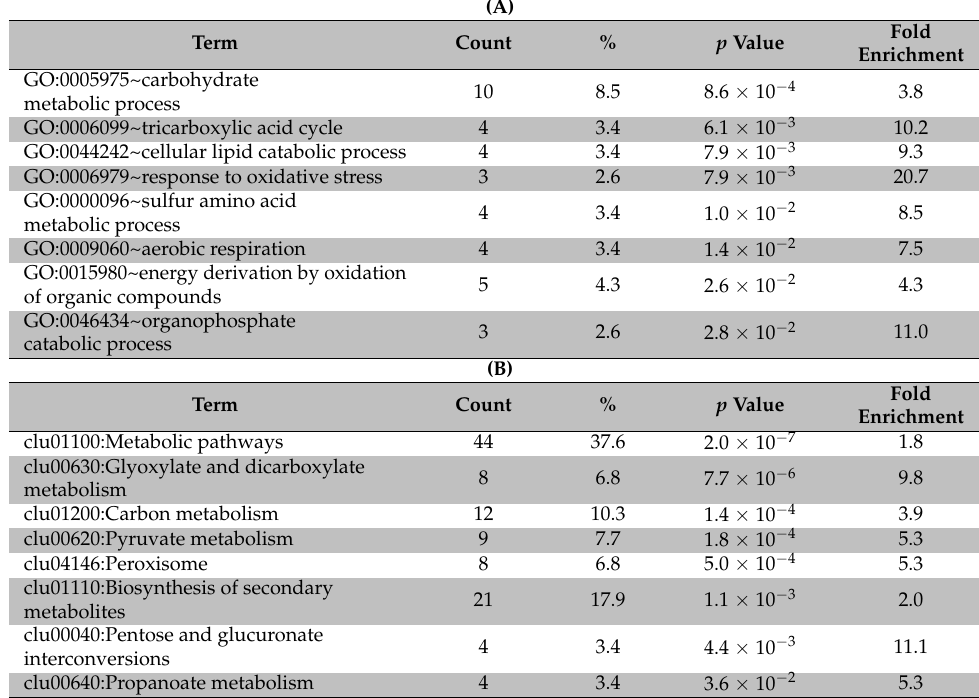
Table 3. Enrichment analysis of the proteins up-regulated in the REC strain (carrying the med15 ∆ mutation) compared with the WT strain. We used DAVID tool (https://david.ncifcrf.gov, accessed on 21 February 2023) with the GO term biological process (A) or KEGG pathway (B) category and C. lusitaniae ATCC42720 as the reference proteome. p value (Ease score) cut-off was set up at 0.05. The table shows only minimally overlapping GO